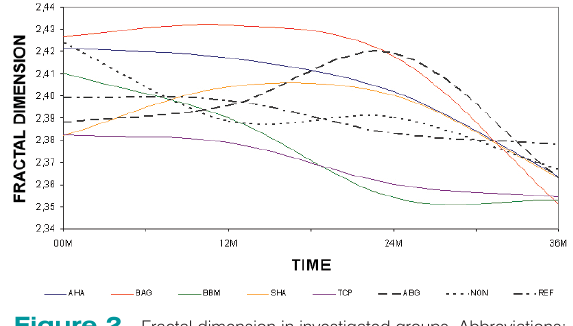
Figure 2. Fractal dimension in investigated groups. Abbreviations: 00M – state immediately after operation, 12M – twelve months after surgery, 24M – twenty four months after surgery, 36M – thirty six months after surgery. AHA - Slow alterations in ROI lead in final observation to less heterogenous texture of implantation site. BAG – Gradual, slow homogenization of internal structure of implantarion site, finally done significantly simpler texture. BBM – the most noticeable changes were observed during first year after implantation, significantly more homogenous radiotexture was stable two and next three years post-operationally.